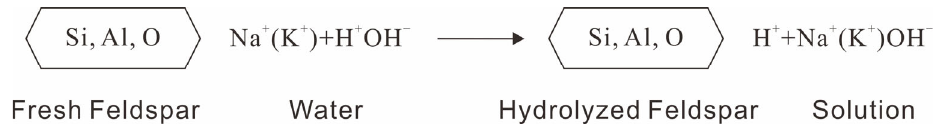
Figure 11. The process of feldspar hydrolysis [44].